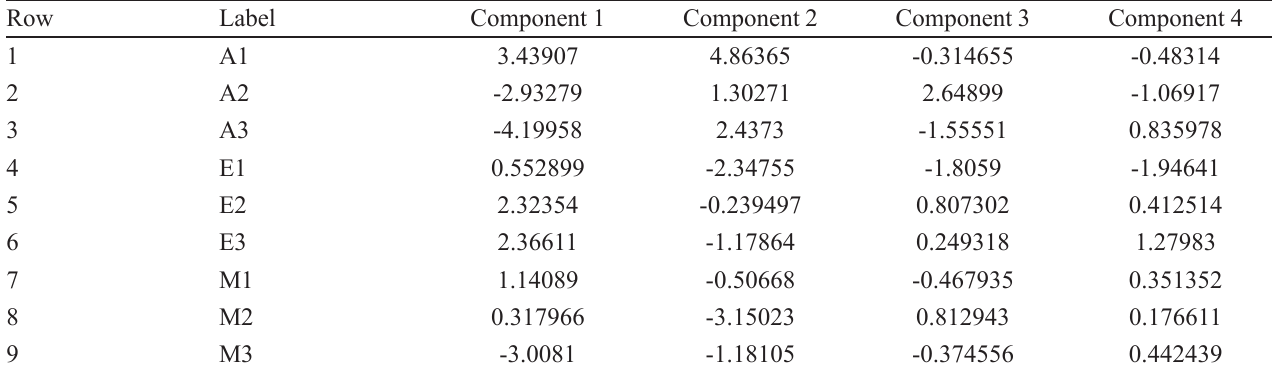
TABLE IV - Composition of each component based on correlation weight per recrystallized particle Row